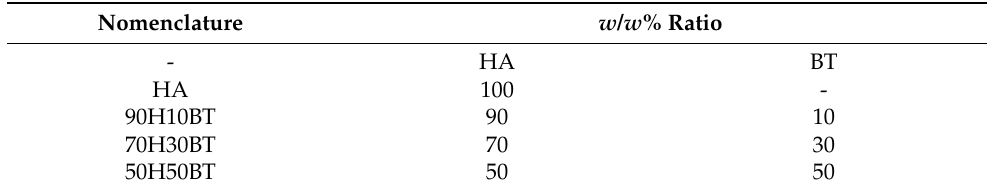
Table 1. Nomenclature used for different weight percent ratio of HA-BT composite.